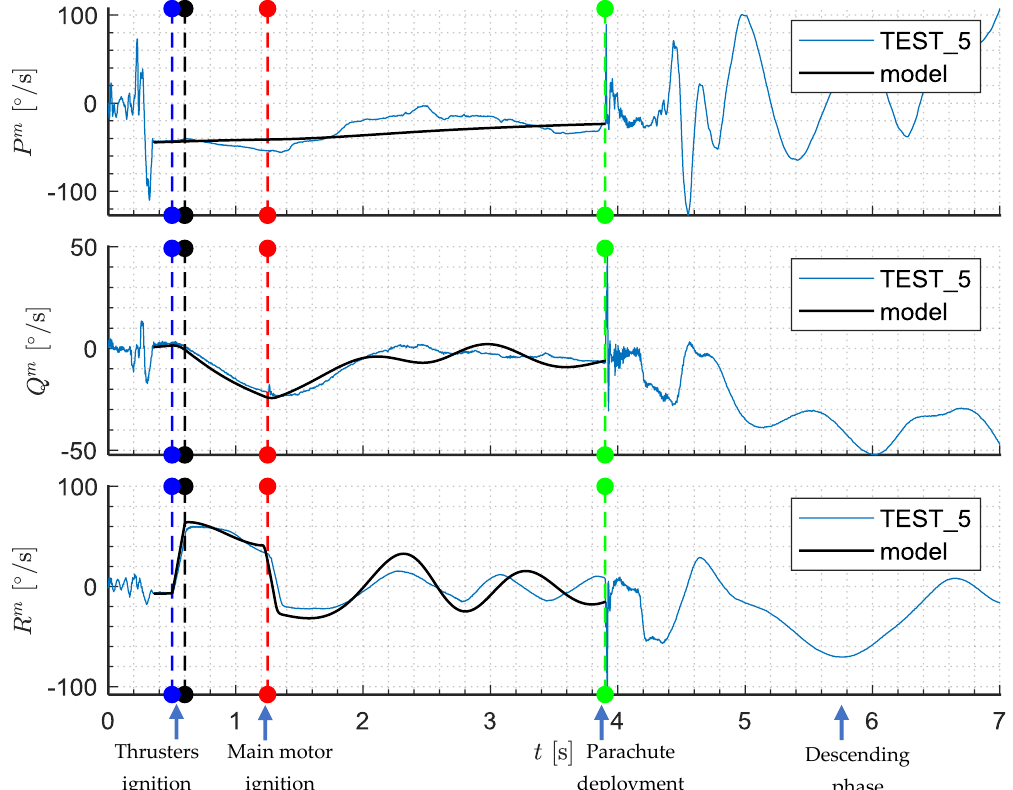
Figure 27. Angular rates (test 5, thrusters mounted behind the center of mass). Aerospace 2020 , 7 , x FOR PEER REVIEW